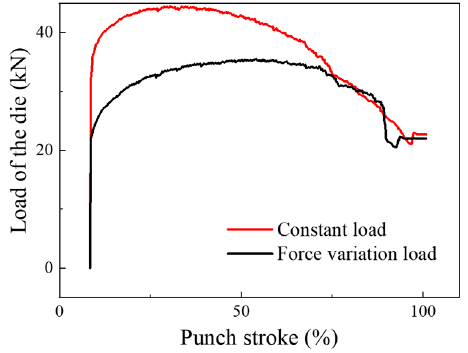
Figure 6. Comparison of mold load under force variation load and constant load.